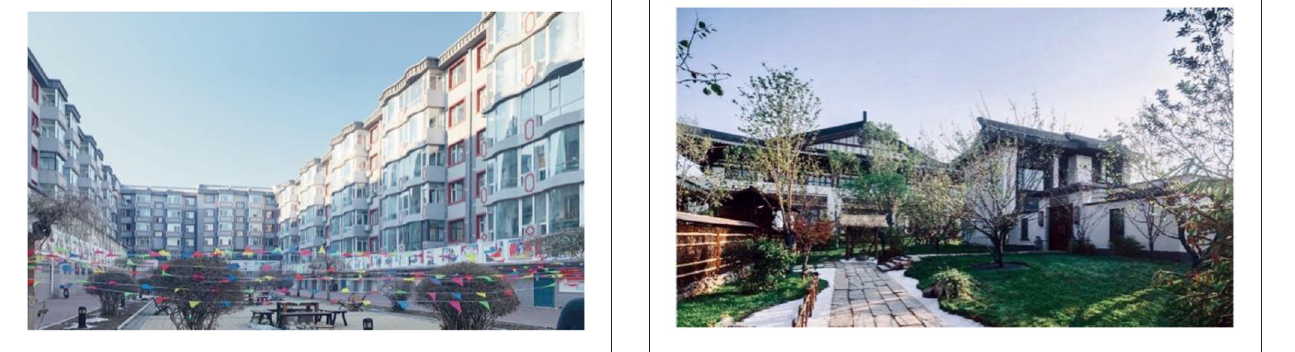
FIGURE 3 | High density residential area in Changchun buildings (Source: Authors).